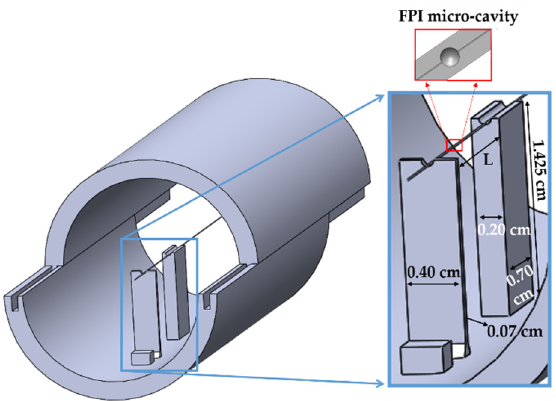
Figure 3. Schematic representation of the overall sensing system detailing the pair of rods configu- ration and its respective